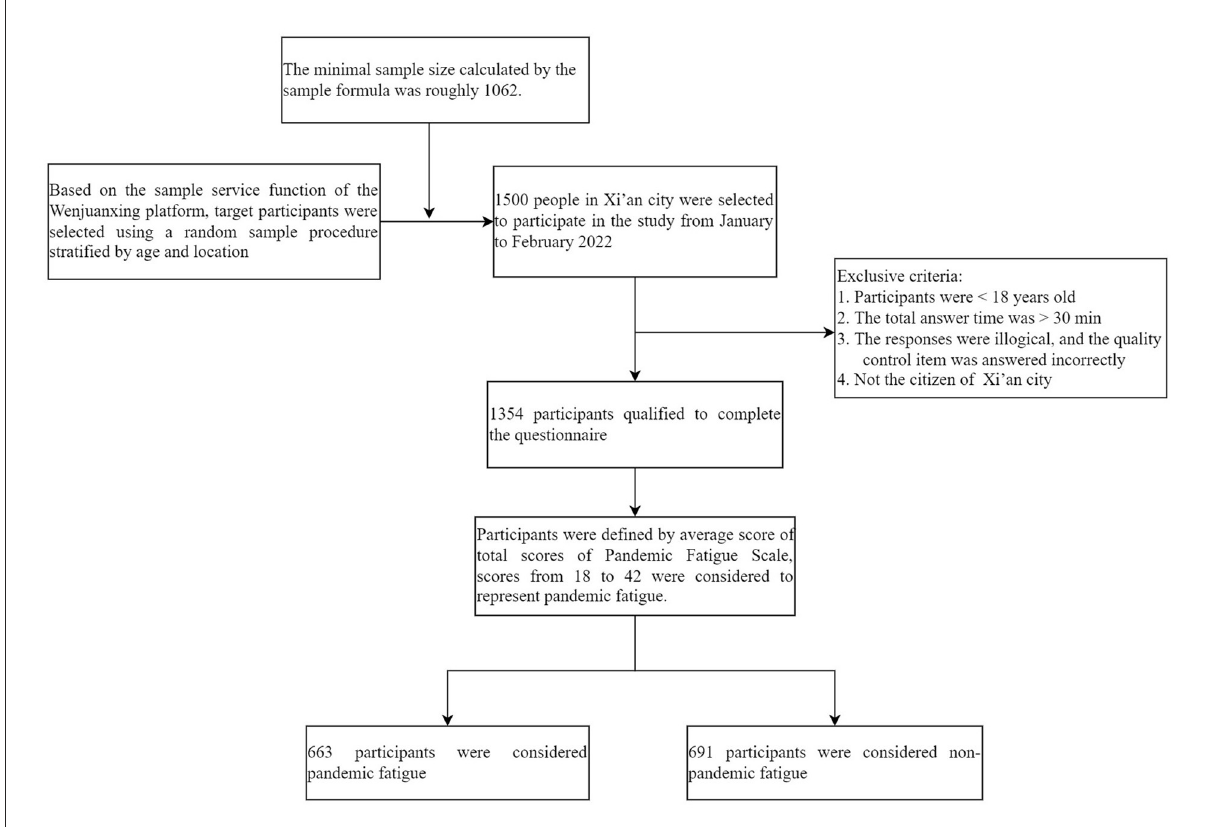
FIGURE1 Flowchart of participants inclusion and